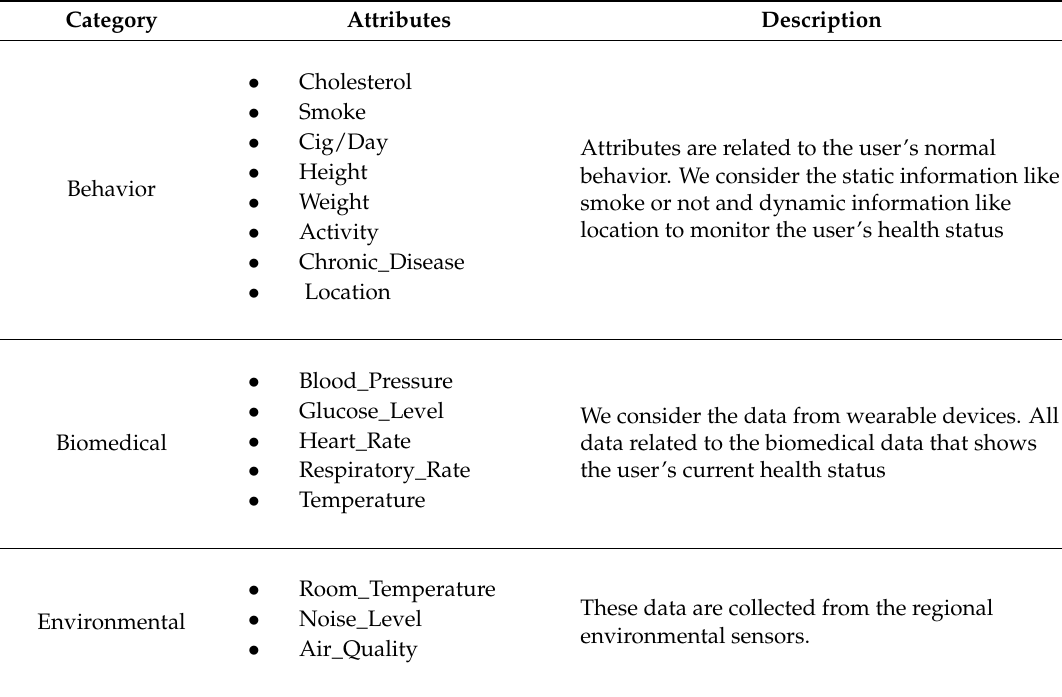
Table 3. Attributes